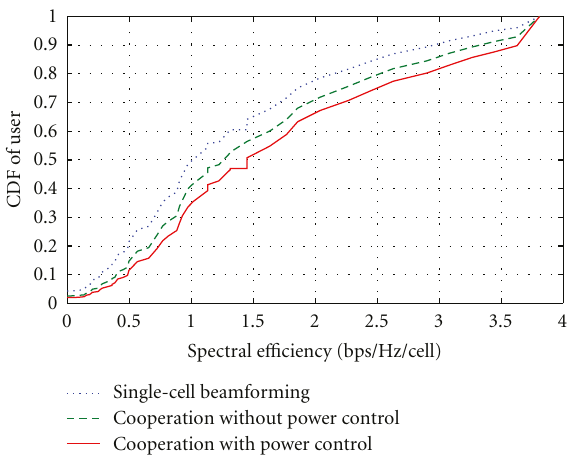
Figure 7: CDF of Spectral E ffi ciency when UEs employ one antenna each.